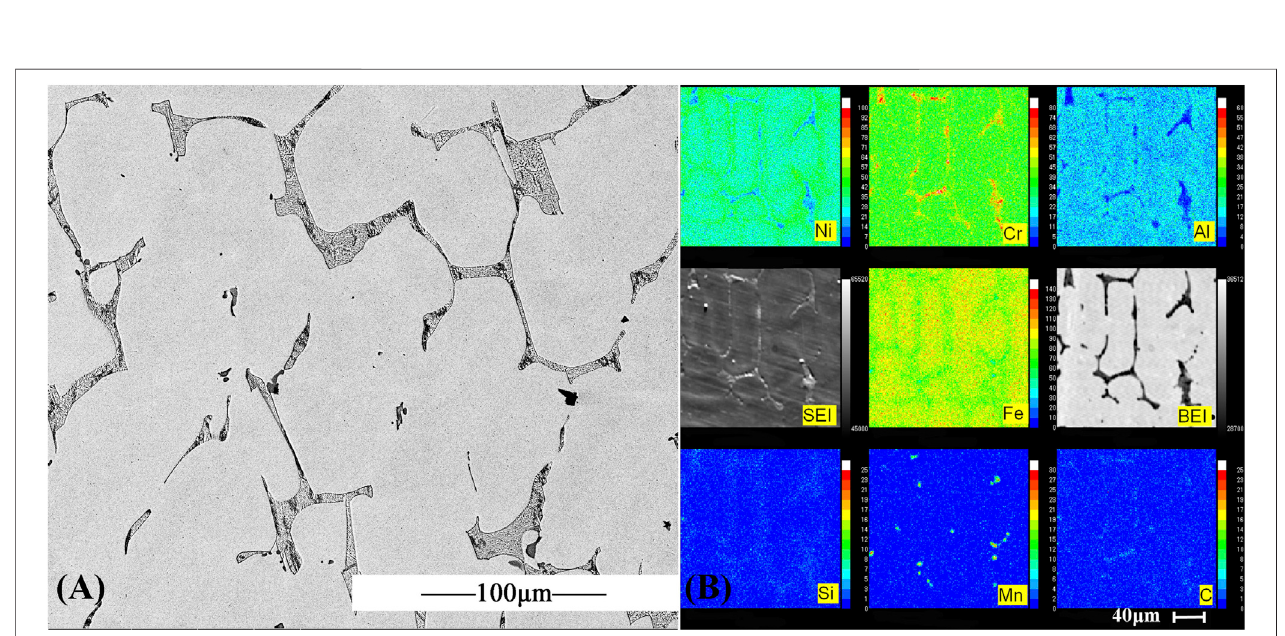
FIGURE 1 | As-cast microstructure of AFA 310S after melting: (A) SEM image, (B) EPMA image.